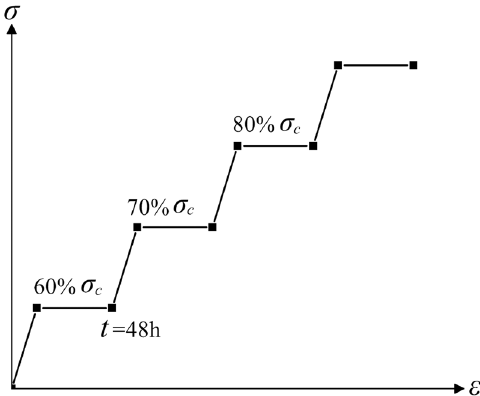
Figure 2: Schematic of loading path in triaxial compression test with step loading.